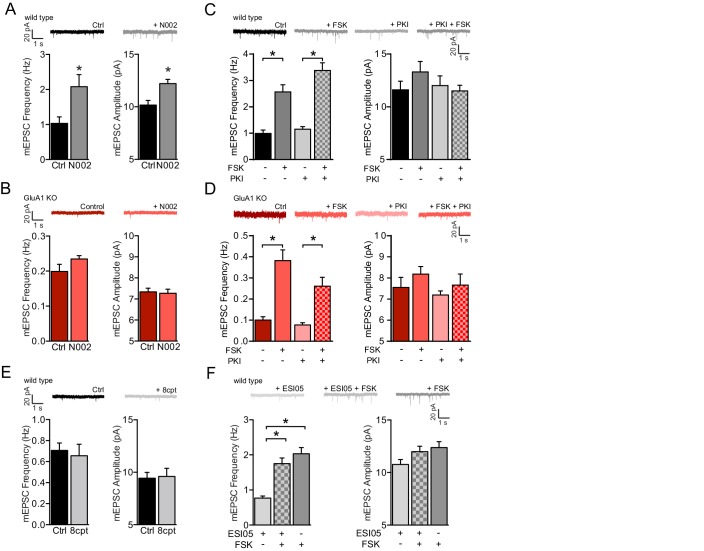
PKA and Epac activation are not sufficient to activate GluA2/3-plasticity.(A) Example traces, mEPSC recordings of WT neurons with (n=12) or without (n=13) PKA agonist N002 in the recording pipette. N002 increased mEPSC frequency (t-test, p=0.004) and mEPSC amplitude (t-test, p=0.007). (B) Example traces, mEPSC recordings from GluA1-KO neurons with (n=13) or without (n=15) N002 in the recording pipette. N002 did not increase mEPSC frequency (t-test, p=0.06) and mEPSC amplitude (t-test, p=0.8) when GluA1 is not expressed. (C) Example traces, mEPSC frequencies and mEPSC amplitudes of untreated CA1 neurons (n=8), neurons incubated with forskolin (n=9), incubated with PKA inhibitor PKI (n=7), or preincubated with PKI prior to forskolin (n=10). PKI did not prevent the forskolin-driven increase in mEPSC frequency (ANOVA, ctrl vs FSK: p<0.0001, PKI vs FSK/PKI: p<0.0001). (D) Same as for (B) for GluA1-KO CA1 neurons either untreated (n=4), incubated with forskolin (n=5), incubated with PKI (n=5), or preincubated with PKI prior to forskolin (n=5) (ANOVA, ctrl vs FSK: p<0.0001, PKI vs FSK/PKI: p=0.0001). (E) mEPSC recordings from wildtype CA1 neurons with control intracellular solution (n=7) or with Epac activator 8-CPT-2Me-cAMP in the recording pipette (n=7). 8-CPT-2Me-cAMP did not increase average mEPSC frequency (t-test, p=0.5) or amplitude (t-test, p=0.9) (F) WT CA1 neurons incubated with Epac inhibitor ESI-05 (n=12), forskolin (n=10) or preincubated with ESI-05 prior to forskolin (n=15). ESI-05 did not prevent the forskolin-driven synaptic potentiation (ANOVA, ESI-05 vs ESI-05/FSK: p<0.0001; ESI-05 vs FSK: p<0.0001; ESI-05/FSK vs FSK: p=0.4). Error bars indicate SEM, * indicates p<0.05.